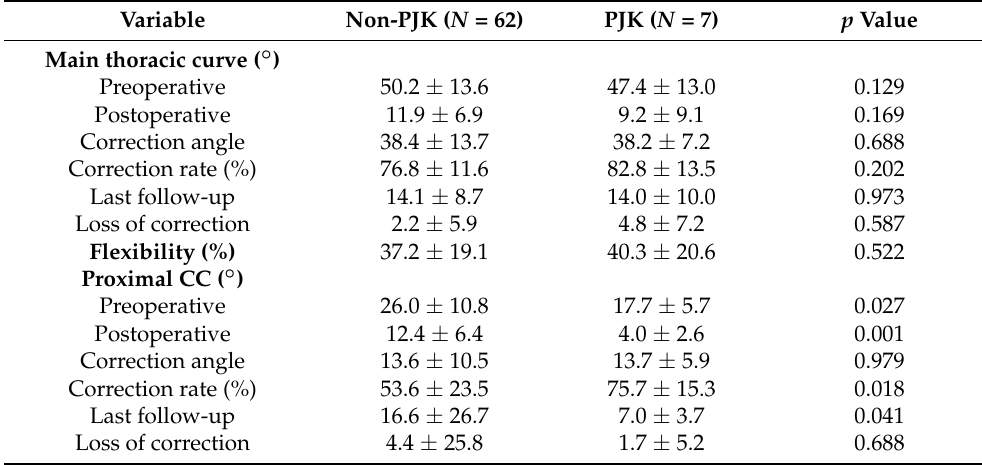
Table 2. Comparison of main thoracic, proximal, and lumbar curves between the non-PJK and PJK